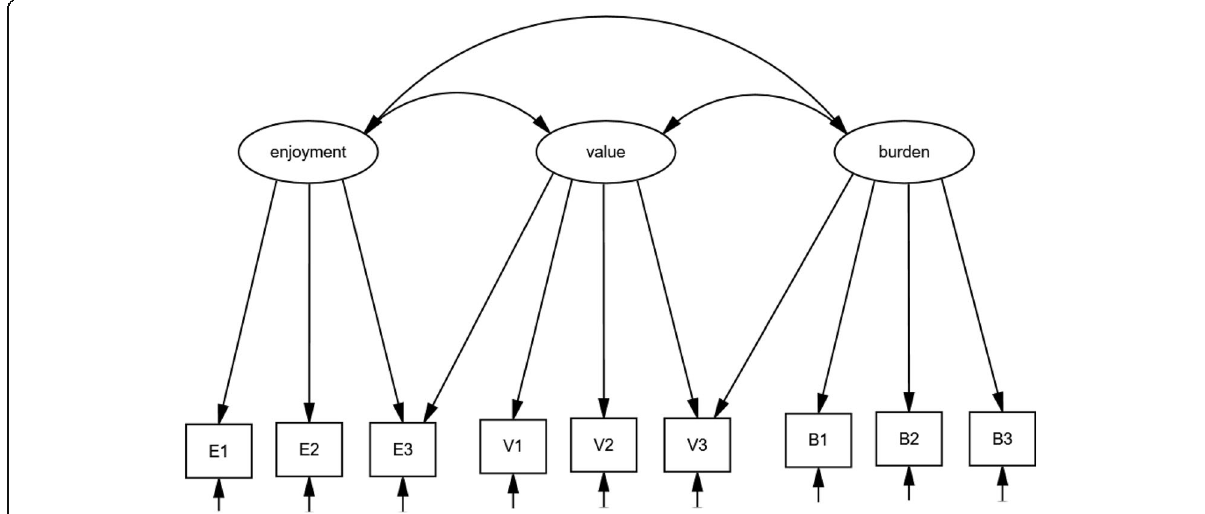
Fig. 1 Final factor model for the survey attitude scale